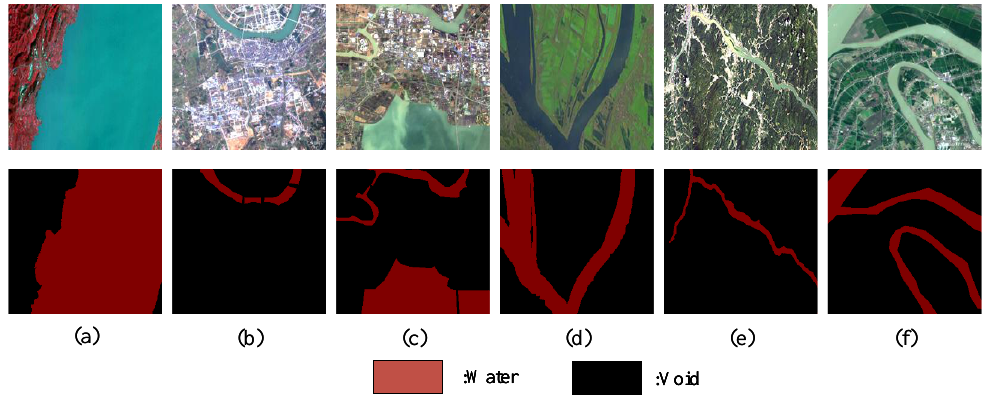
Figure 8. Waters’ segmentation dataset part of the picture display. ( a ) Sea; ( b ) Urban residential area; ( c ) Coastal area; ( d ) Rivers; ( e ) Highland area; ( f ) Terraced